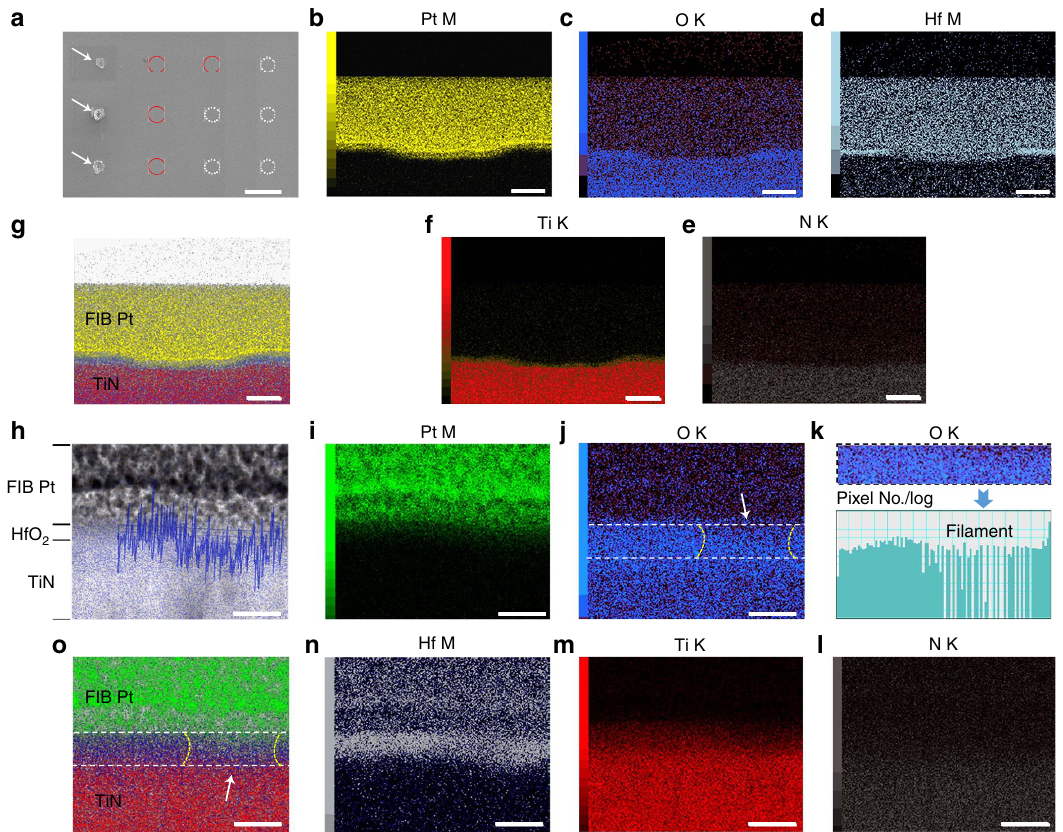
Figure 5 | Direct identification of oxygen-deficient conducting filament in HfO 2 . ( a ) Scanning electron microscopy image showing a collection of electrically stimulated local regions using conductive atomic force microscopy. The regions were set into different controlled resistance states by applying varied programming conditions. The arrows indicate regions undergoing severe structural deformations by applying strong programming conditions, while the solid red and dotted white circles suggest regions existing at pristine and intermediate switching states by applying weak and moderate programming conditions, respectively. Scale bar, 2 m m. ( b – f ) Energy-dispersive X-ray spectroscopy (EDS) mapping of Pt M, O K, Hf M, Ti K and N K edges and ( g ) overlaid mapping results in a volcano region with structural deformations. Scale bar, 100nm. ( h ) High-angle annular dark-field scanning transmission electron microscopy image overlaid with O K line profile and EDS mapping, showing formation of an oxygen-deficient filament in HfO 2 . Scale bar, 10nm. ( i – n ) EDS mapping of Pt M, O K, N K, Ti K, Hf M edges and ( o ) overlaid mapping results for the same region shown in h . The contour of the filament region was indicated by the dashed lines and the arrows. The histogram of O K edge signal in the HfO 2 film is also shown in k , highlighting the existence of an oxygen-deficient conduction channel on the right side of the HfO 2 film. Scale bar,